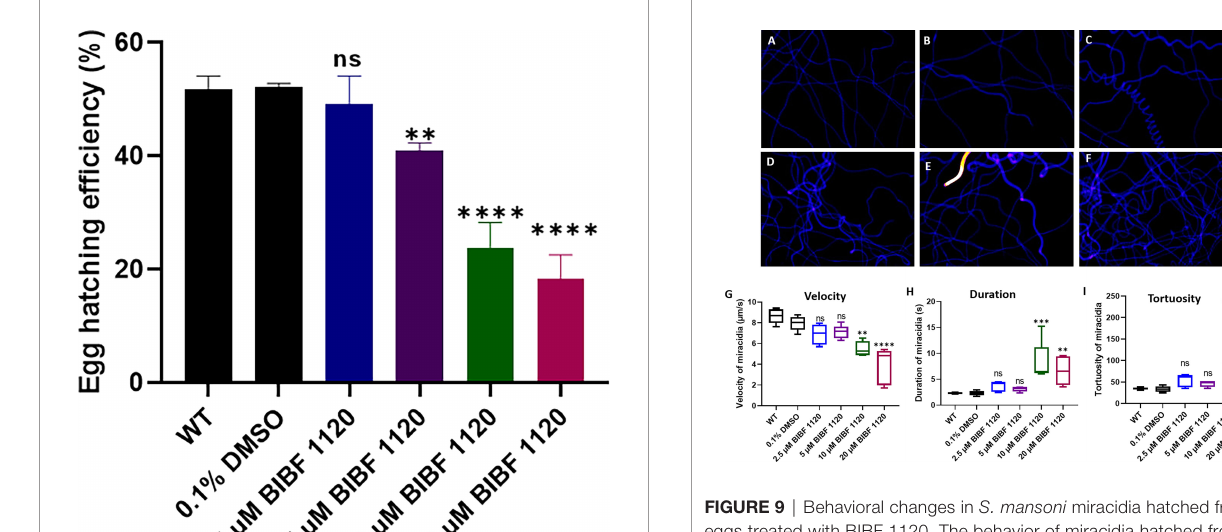
Figure 9G , the swimming velocity of miracidia hatched from eggs treated with 10 m M and 20 m M BIBF 1120 was signi fi cantly decreased by 30.7% ( p =0.0023) and 51.3% ( p ≤ 0.0001), respectively, compared with that measured in the 0.1% DMSO- treated group. Markedly, the average time duration of miracidia hatched from eggs treated with 10 m M and 20 m M BIBF 1120 in the FOV was elevated by 72.1% ( p =0.0006) and 72.7% ( p =0.0088),